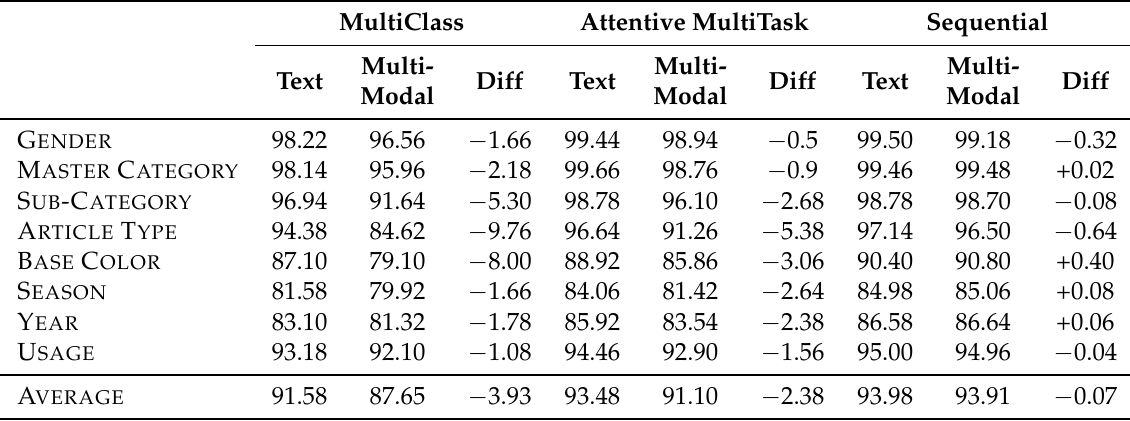
Table 7. Attribute accuracies on the Kaggle dataset for all models using both text and multimodal inputs. The Diff column shows the difference between the multimodal and text-only